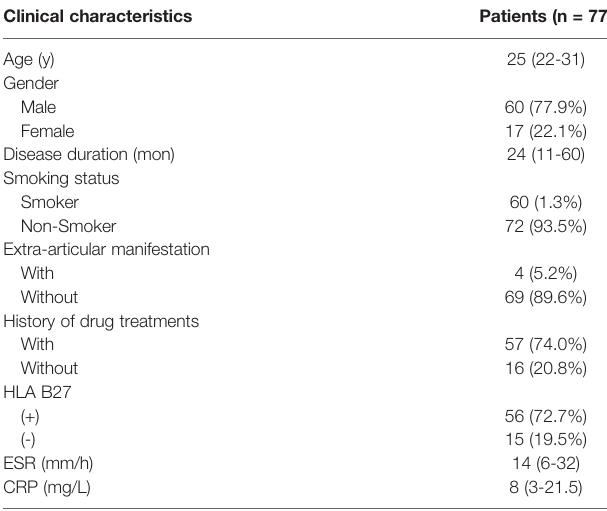
TABLE 1 | Patient characteristics.